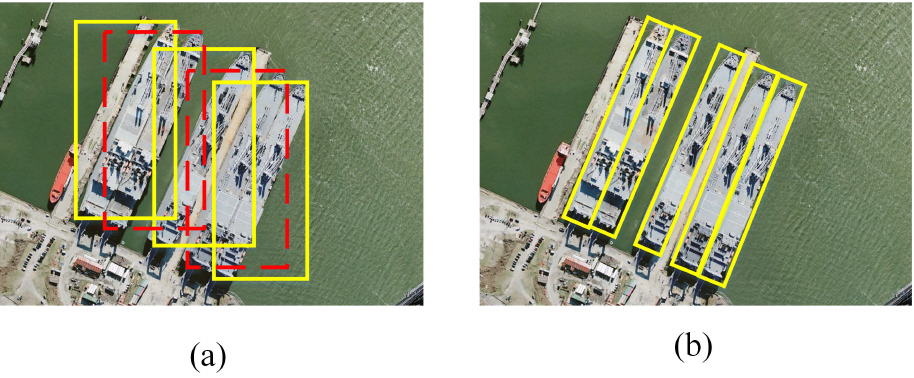
Figure 1. ( a ) The situation of missed detection due to too dense targets. The yellow box indicates the detected targets, and the red box indicates the missed targets. ( b ) The result of using the oriented bounding